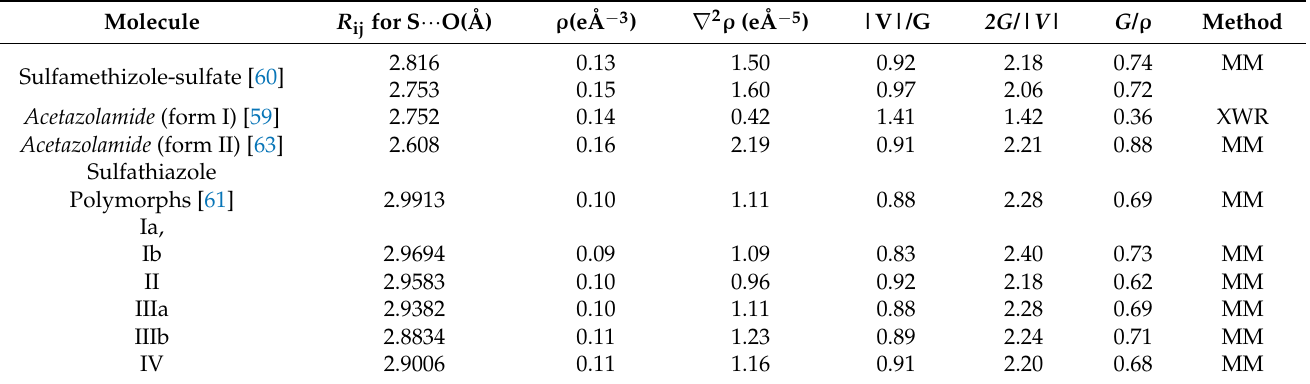
Table 4. Topological parameters of intramolecular S ··· O chalcogen bonds in a series of sulfa drugs ob- tained from experimental charge density studies. Table and Figure reproduced from Thomas et al. [62].